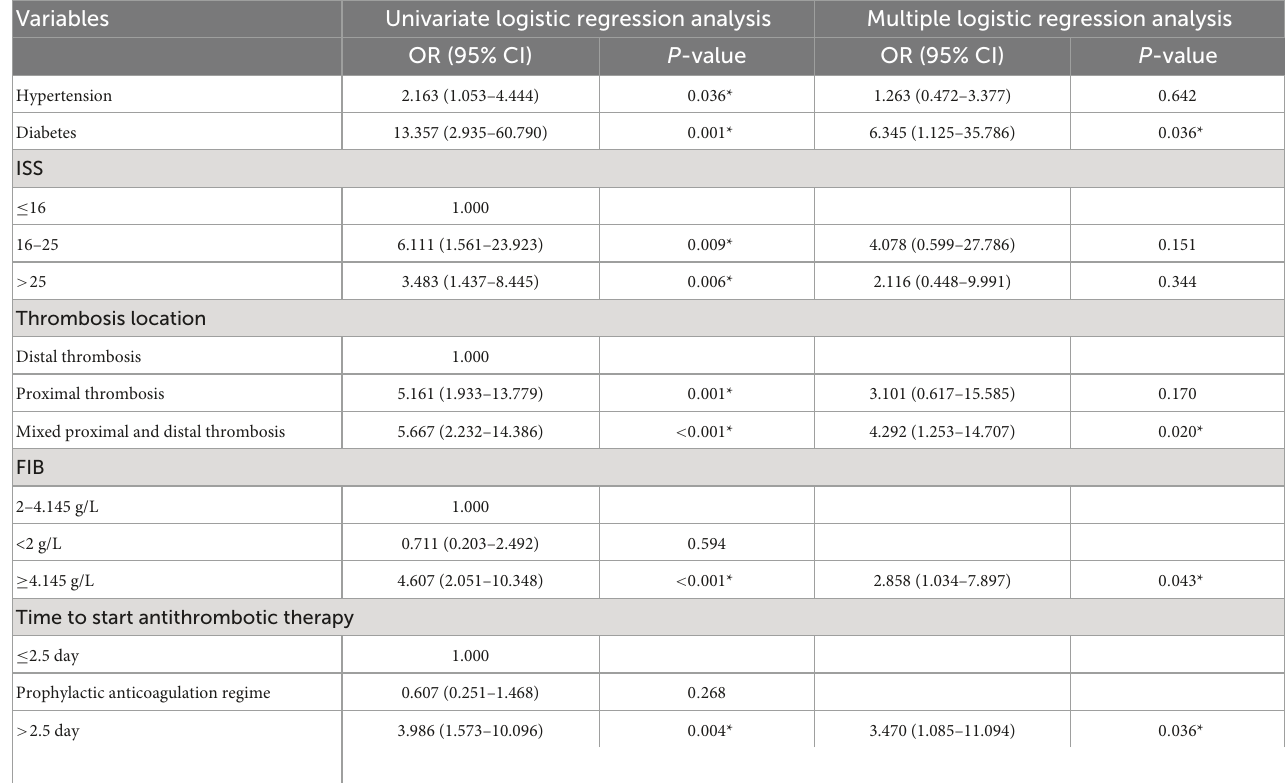
TABLE 4 Multivariate logistic regression analysis of factors associated with preoperative RVT.